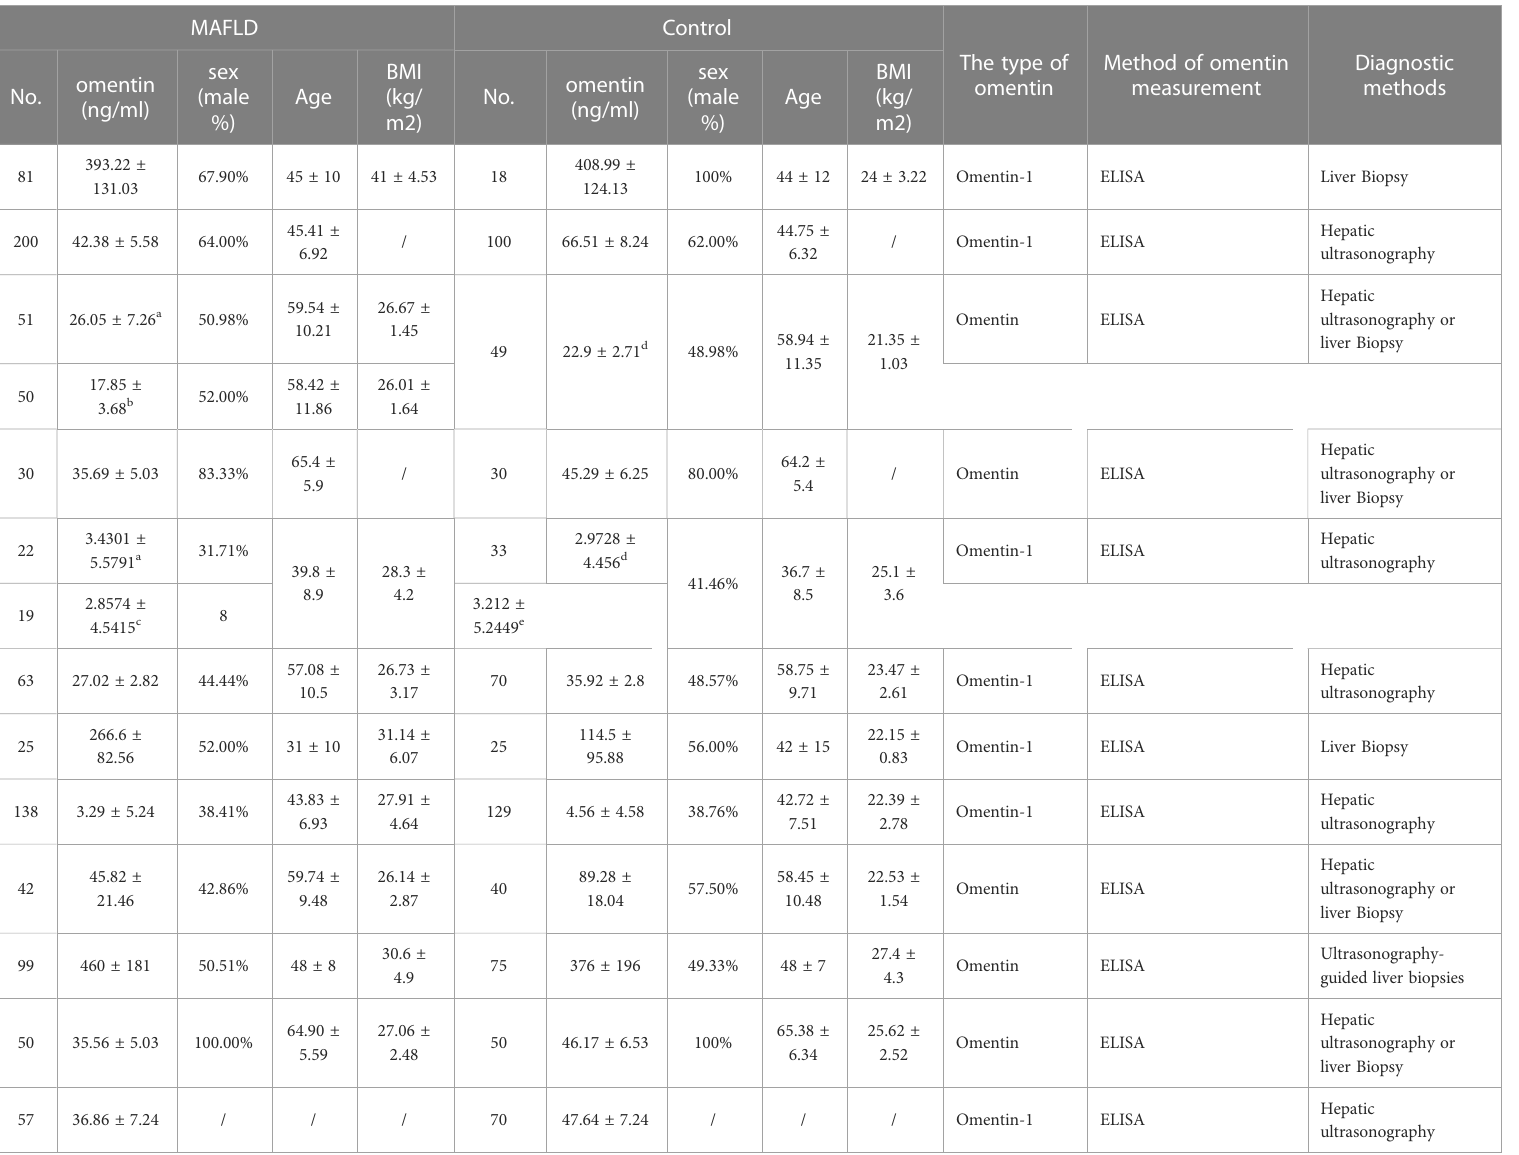
TABLE 1 Baseline characteristics of studies included in the